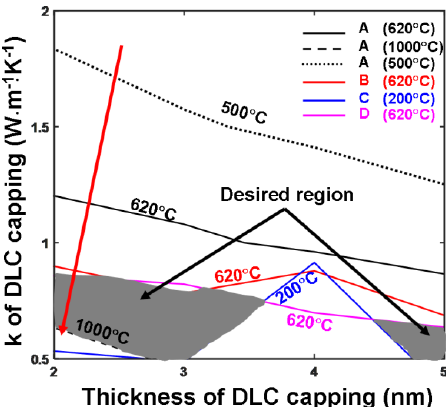
Figure 4. Temperature contours at points A, B, C, D as a function of thermal conductivities and thickness of the DLC capping layer. For both simulations, the electrical conductivities of the capping and under layer remained at 0.5 W·m −1 ·K −1 and 12 W·m −1 ·K −1 , while other modeling parameters are given in Table 1. The write pulses for all simulations were maintained as 4 V of 120 ns. The red arrow indicates the direction along which the temperature at A increased.